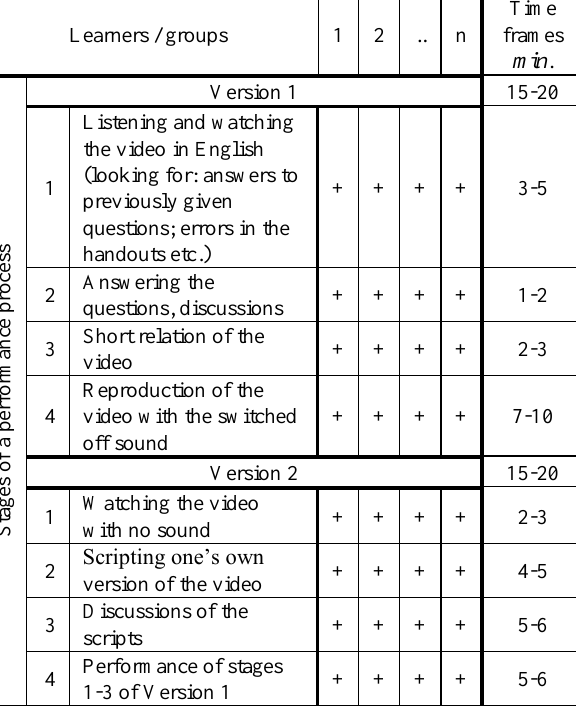
Table 5. Stages and time frames of work with video